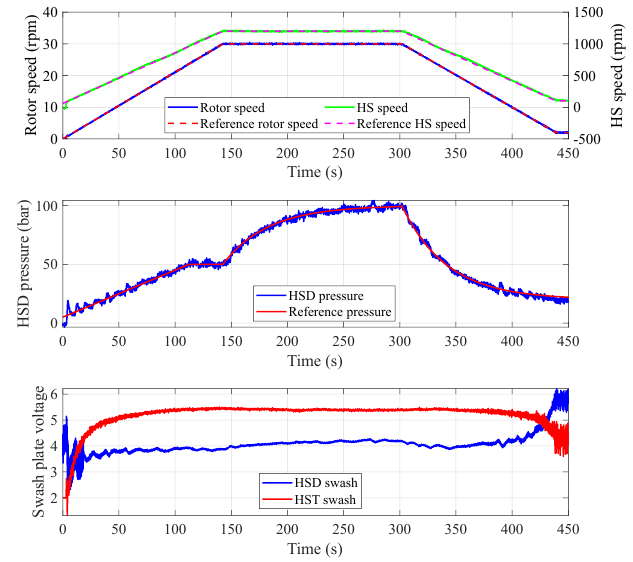
Figure 15. Experimental results of start and stop phase. Small pressure oscillations at low pressure can be attributed to negligible pressure damping of the system, arising due to near-zero leakage in the hydraulic components. The amplitude of the oscillation has been minimized by introducing a bypass circuit in the HSD. The HSD pump was designed for high-speed operations. During low-speed conditions, the swash plate movement is impeded due to sticking, which prevents pressure